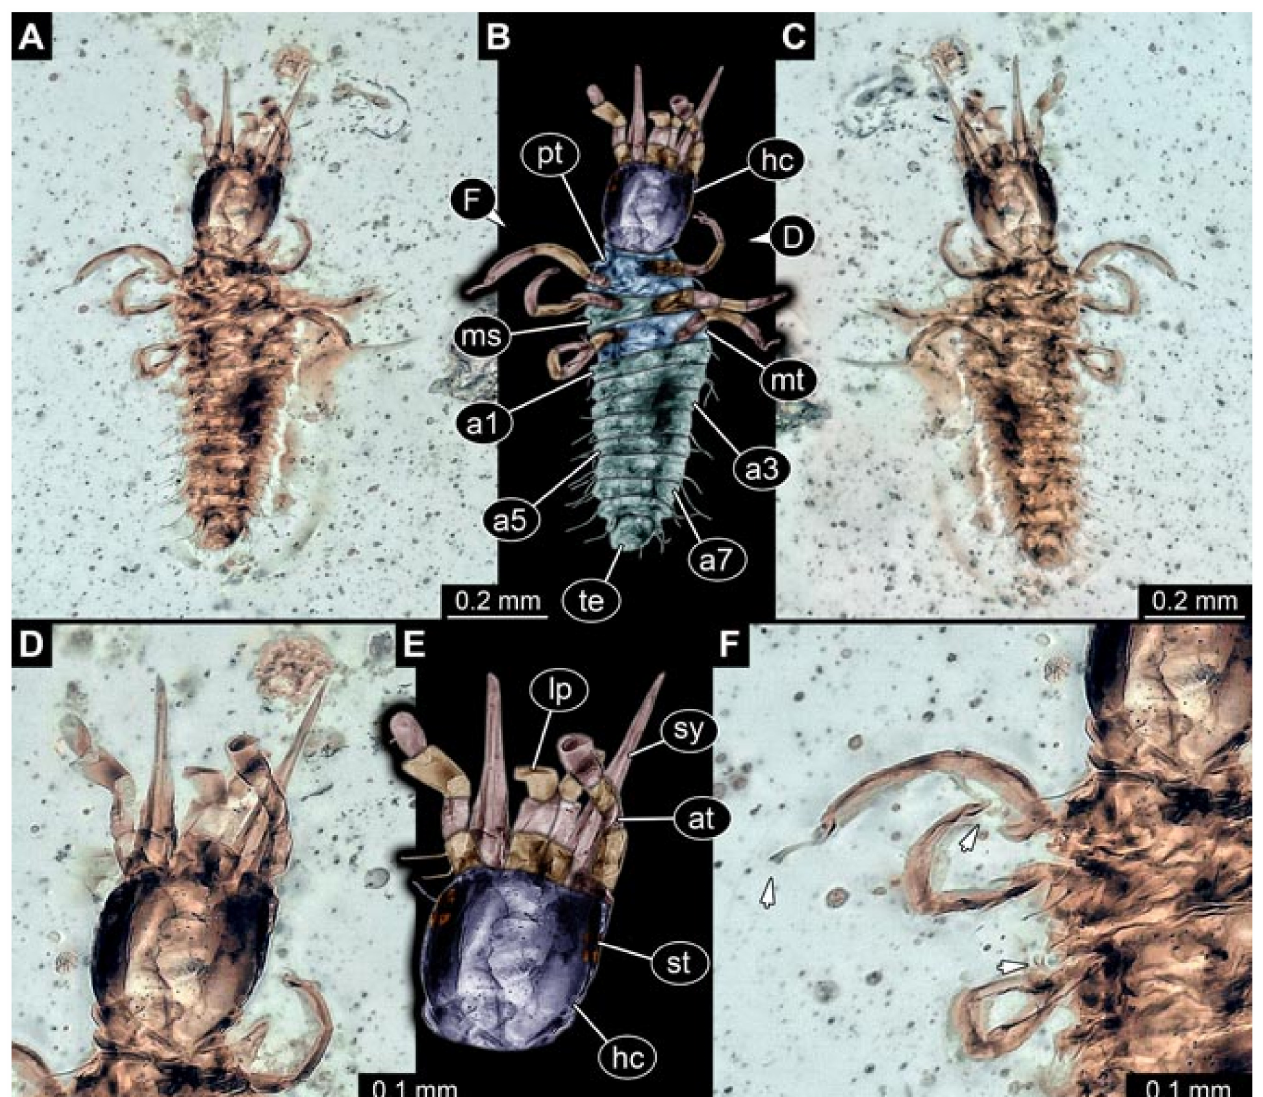
Figure 11. Specimen 5832 (BUB 3963); Myanmar amber. ( A ) Ventral view. ( B ) Ventral view, colour-marked. ( C ) Dorsal view. ( D ) Close-up of head in ventral view. ( E ) Close-up of head in ventral view, colour-marked. ( F ) Close-up of trunk appendages with empodia (arrows) in ventral view. Abbreviations: a1–a7 = abdomen segments 1–7; at = antenna; hc = head capsule; lp = labial palp; ms = mesothorax; mt = metathorax; pt = prothorax; st = stemmata; sy = stylet; te = trunk